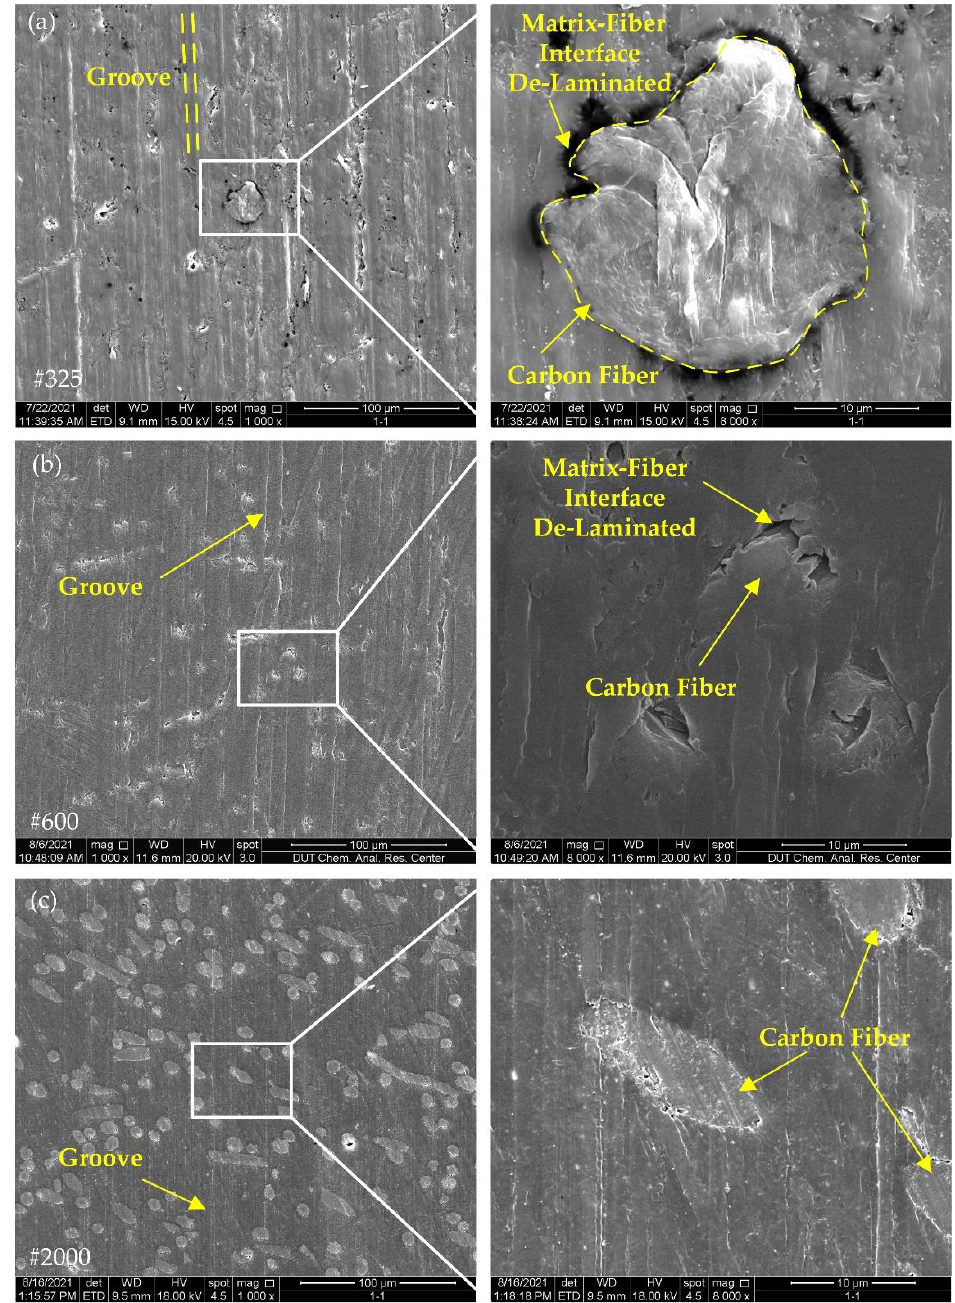
Figure 8. Surface morphology of CF30/PEEK with different grinding wheels: ( a ) grit size #325; ( b ) grit size #600; ( c ) grit size #2000.